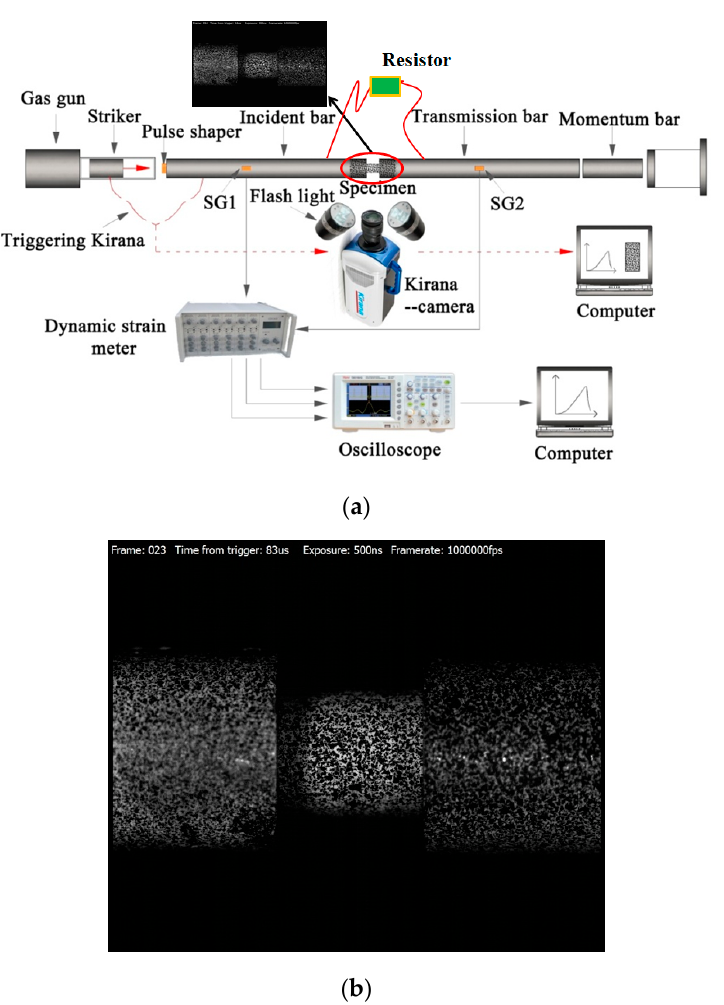
Figure 2. Test system: ( a ) Schematic of the split-Hopkinson pressure bar (SHPB) set-up and the DIC measurement system; ( b ) Surface speckle image of sample and bars.